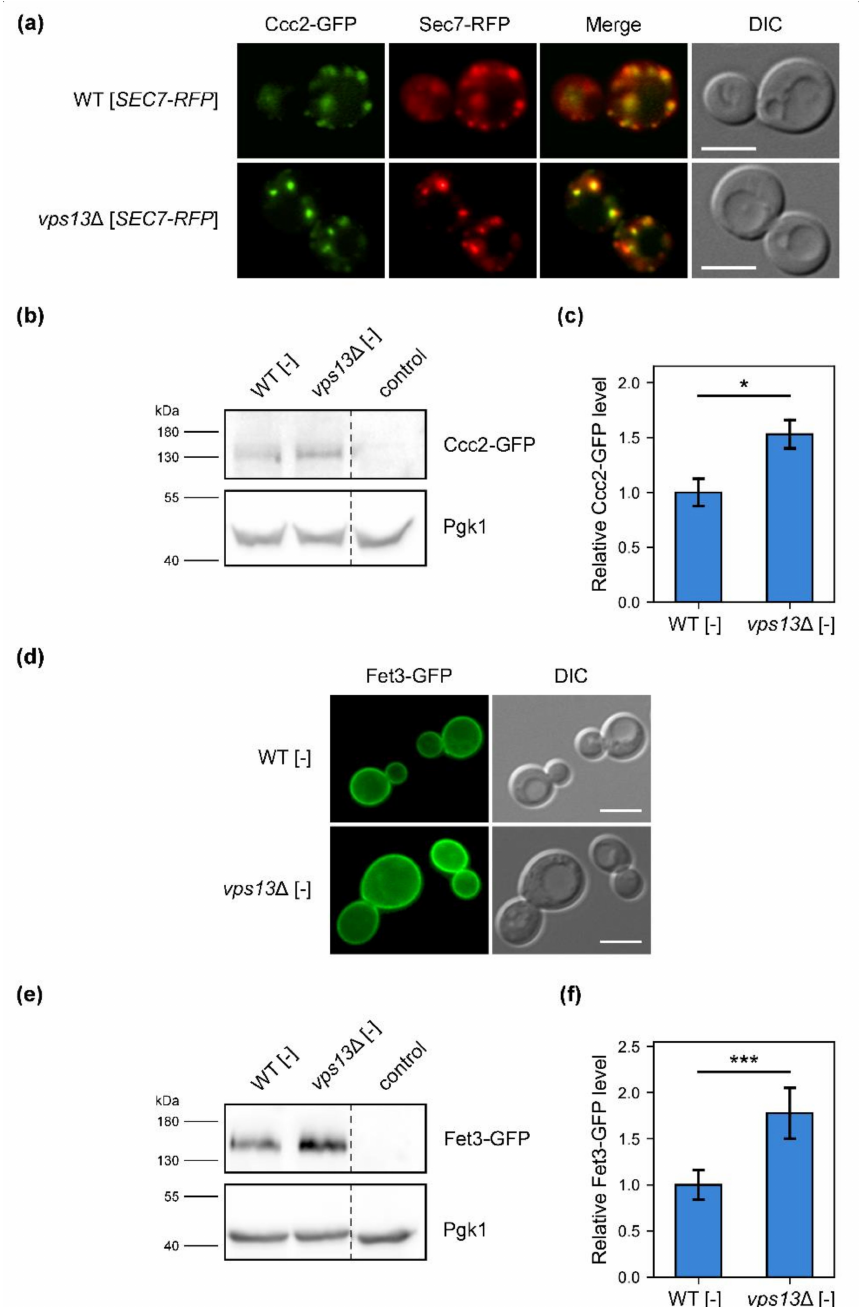
Figure 4. Impact of VPS13 deletion on Ccc2–GFP and Fet3–GFP localisations and levels. ( a , d ) Flu- orescence microscopy images of wild type and vps13 ∆ cells with GFP-tagged Ccc2 ( a ) and Fet3 ( d ) proteins. The Sec7–RFP protein was used as a Golgi apparatus marker in Ccc2–GFP visualisation. To maintain the same cultivating conditions, strains with GFP-tagged Fet3 used for microscopic obser- vations were transformed with empty vectors. Scale bar 5 µ m. ( b , e ) Western blot analysis of protein extracts obtained from yeast with GFP-tagged Ccc2 ( b ) and Fet3 ( e ) proteins. Like in microscopic observations, strains were transformed with empty vector. Anti-GFP antibody was used for protein detection. Pgk1, detected with anti-Pgk1 antibody, was used as a loading control. Extract from yeast cells without GFP tag was used as a negative control (marked as control). ( c , f ) Quantification of western blot results. Relative levels of Ccc2–GFP ( c ) and Fet3–GFP ( f ) (in relation to Pgk1) are shown. Results were analysed by two-tailed Student’s t-test (for Ccc2–GFP: n = 3 and for Fet3–GFP: n = 7; * p < 0.05, *** p < 0.001). Error bars represent